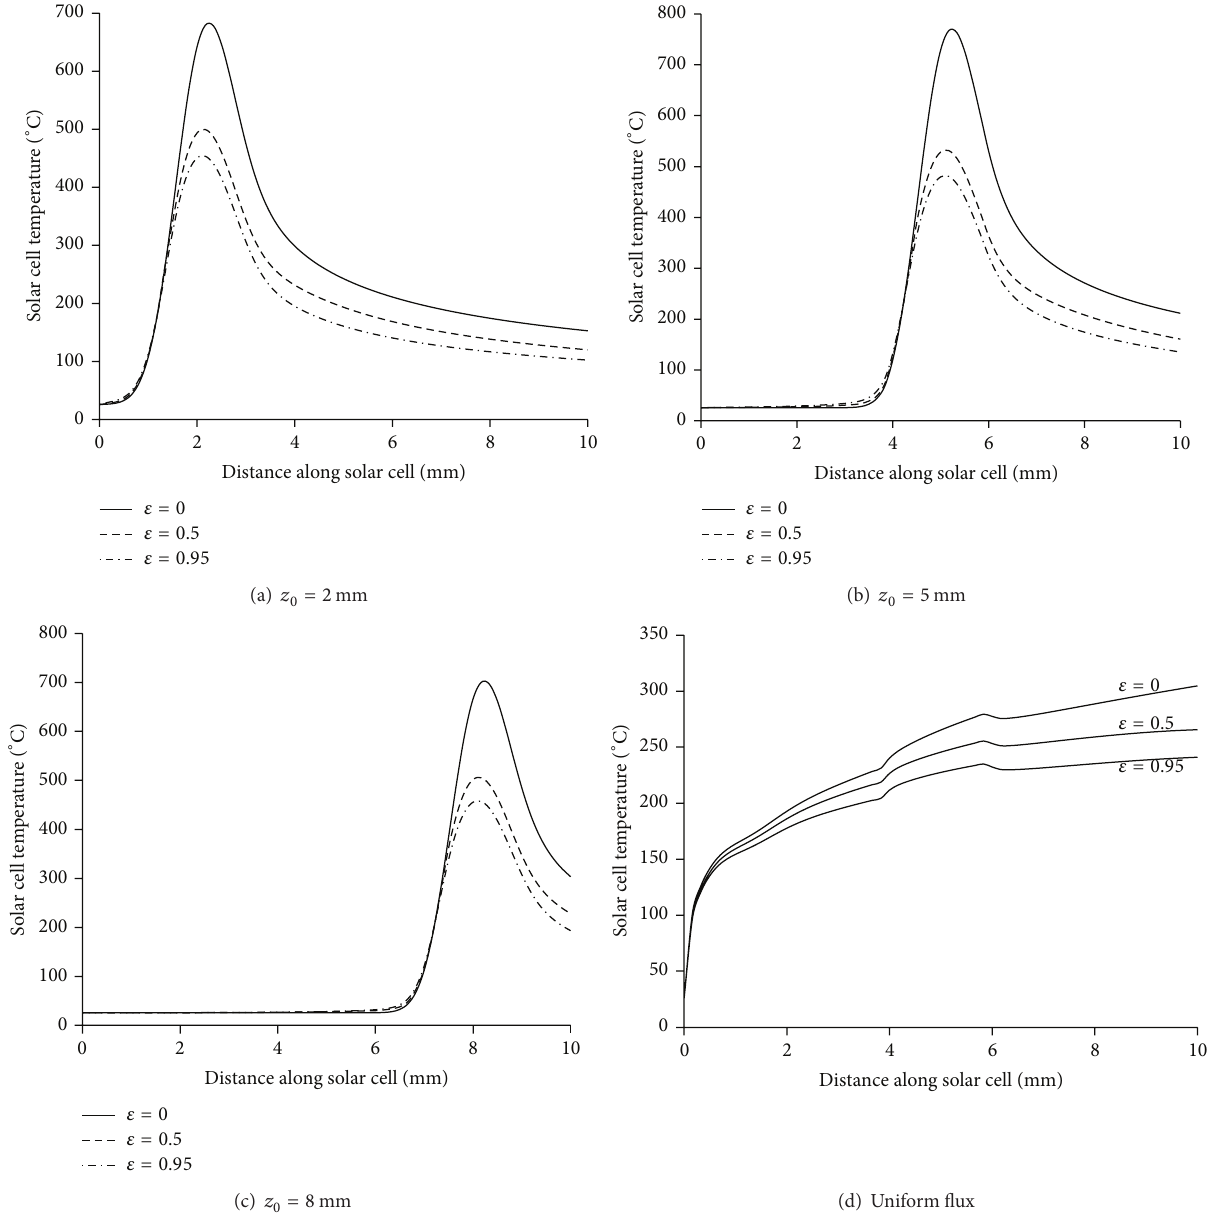
Figure 6: Variations in solar cell temperature obtained using different values of 𝜀 , when SD = 0.001, Re = 500, and 𝐶 = 100 .